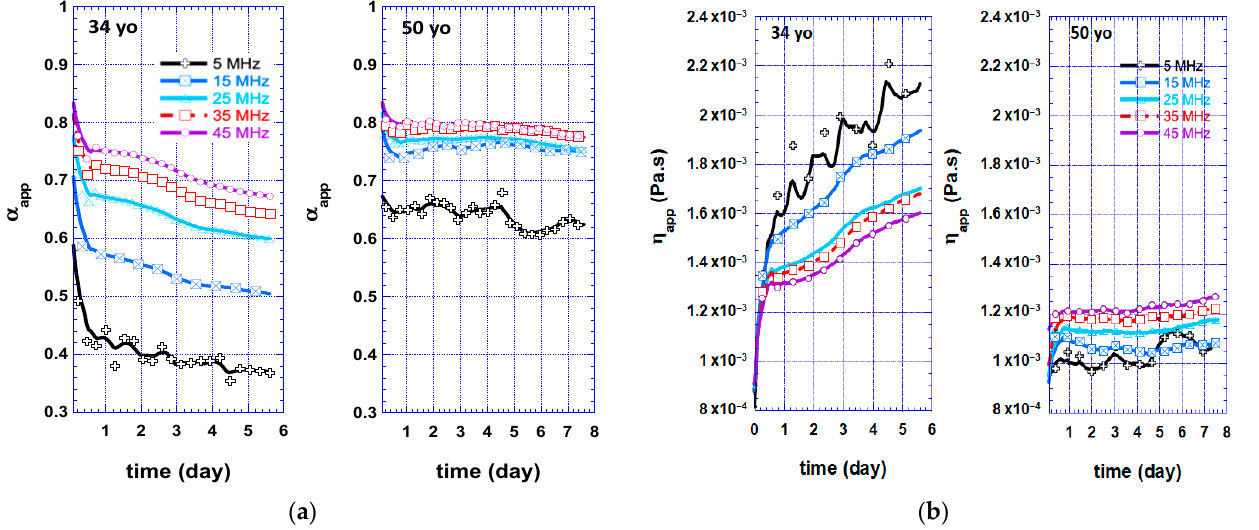
Figure 3. Typical evolution of viscoelastic parameters on a mesoscopic scale: apparent structural parameter α app ( a ) and viscosity η app kinetics ( b ) of skin explant coming from a 34-year-old donor and a 50-year-old donor.